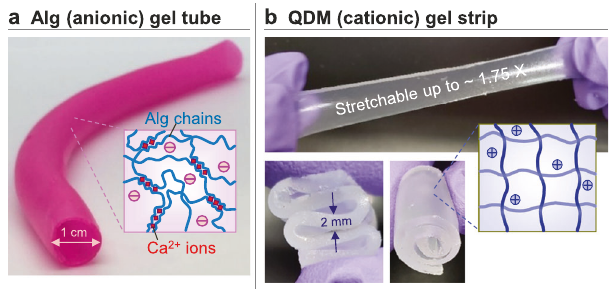
Fig. 1 Gels used in our electroadhesion studies. a Anionic gel of alginate (Alg), crosslinked by divalent Ca 2 + cations. The gel is made in the form of a hollow tube. b Cationic QDM gel strip, made by polymerization of acrylamide derivatives. The photos show that the gel is elastic, stretchable and fl exible. Schematics of the gel structure are shown as insets in each